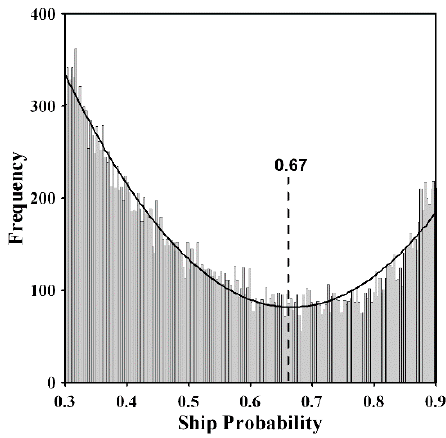
Figure 7. Ship-probability map obtained by using the ANN approach.